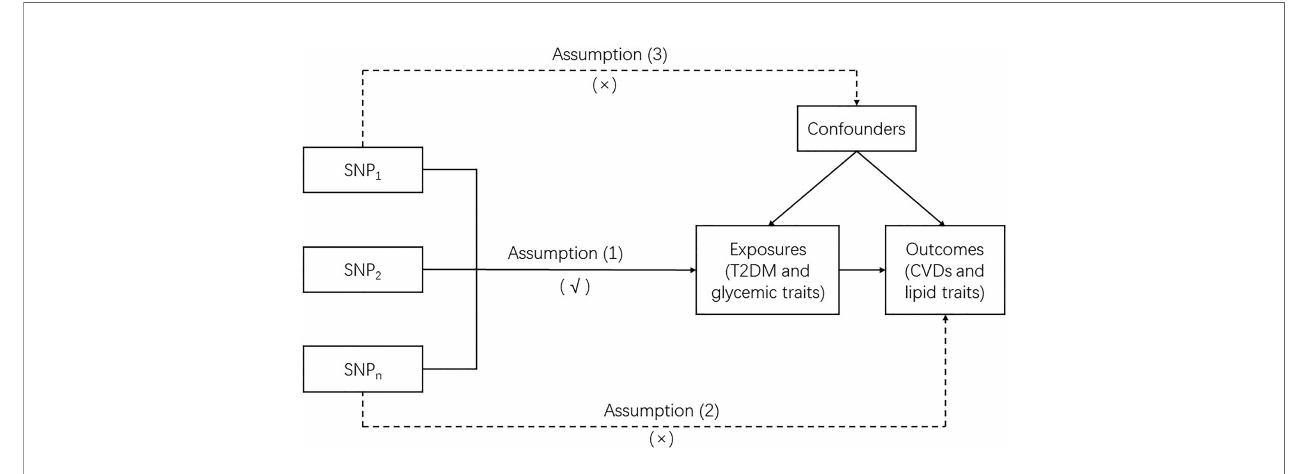
FIGURE 1 | Mendelian